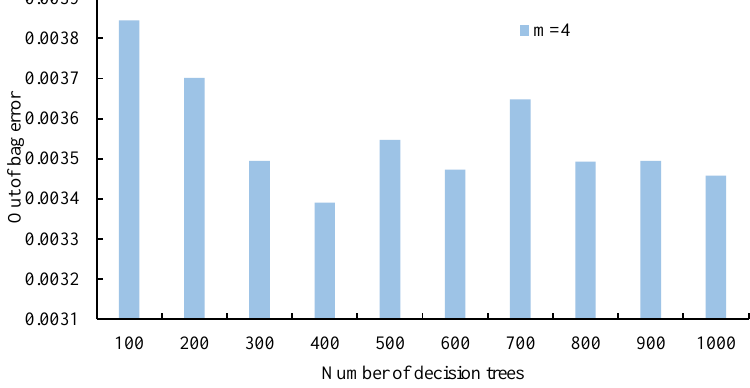
Figure 11. Relationship between number of decision trees and out-of-bag error in